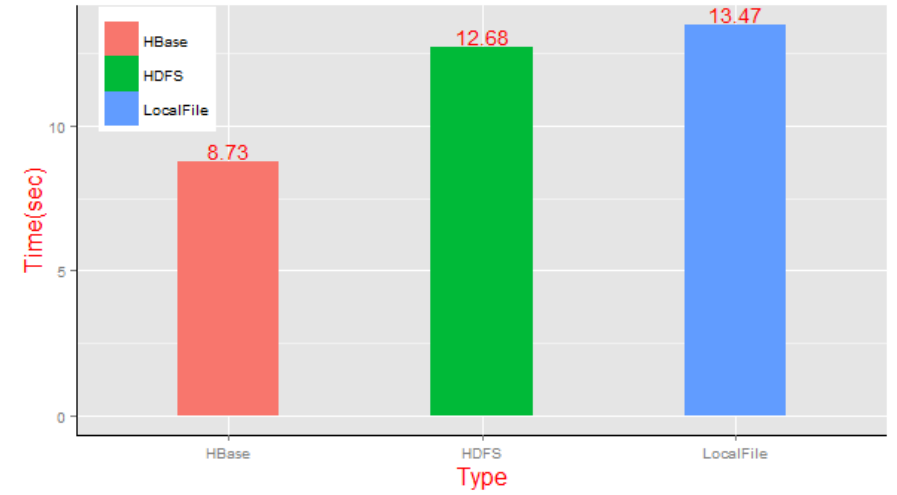
Figure 21. Average response time of dynamic tile clipping by three methods.